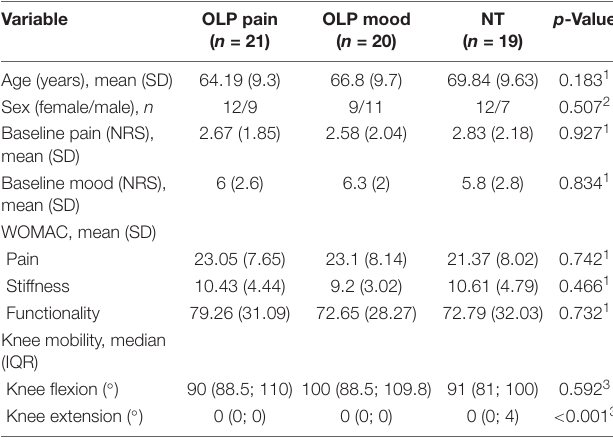
TABLE 1 | Demographic and clinical characteristics at baseline.